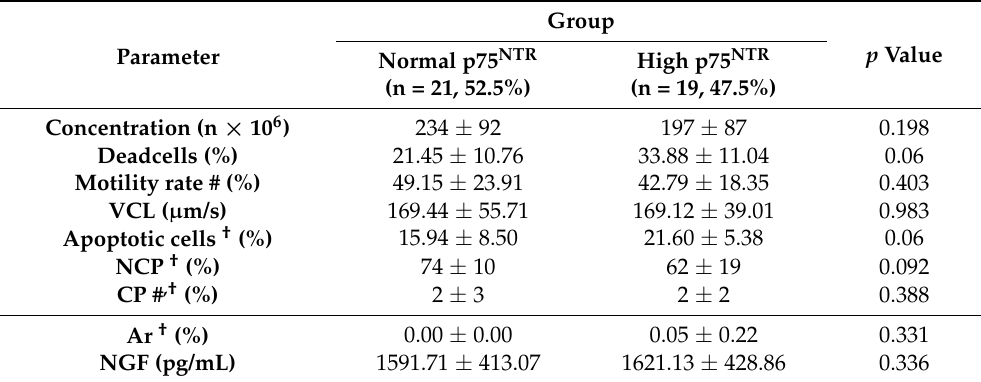
Table 1. Ejaculated sperm traits, NFG, and p75 NTR quantification in the semen of High (>25.6%) and Normal (<25.6%) p75 NTR -positive cells at time